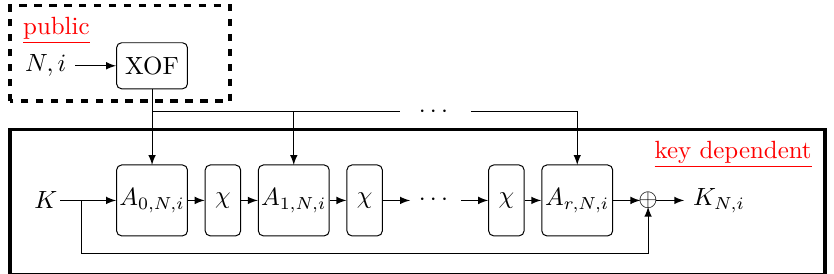
Figure 1: The r -round Rasta construction to generate the key stream K N,i for block i under nonce N with affine layers A j,N,i